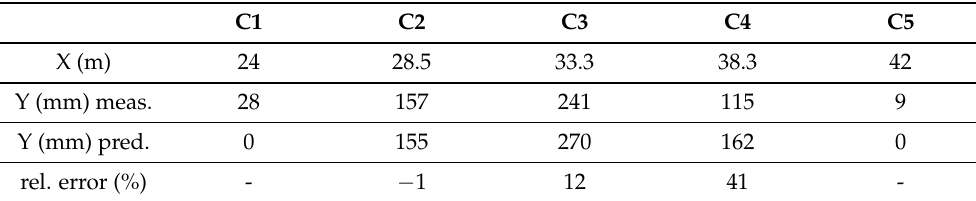
Figure 14. Test 2: predicted and measured deformed configuration. Table 3. Test 2: predicted and measured displacements.